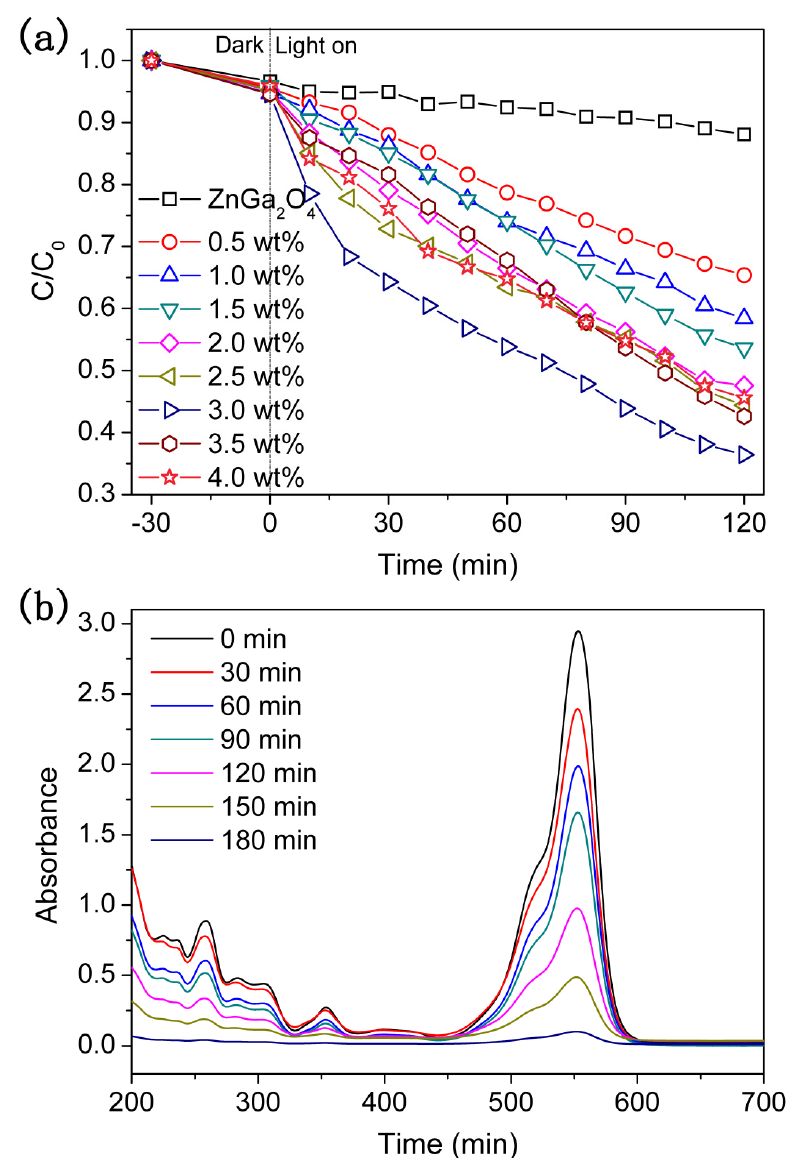
Figure 5. ( a ) The photocatalytic degradation activities of ZnGa 2 O 4 with different amounts of the Au cocatalyst plotted against time; ( b ) The ultraviolet–visible absorption spectra of RhB at different concentrations using 3 wt% Au / ZnGa 2 O 4 photocatalyst. Photocatalytic conditions were: 0.1000 g of photocatalyst, 300 mL of 13.3 ppm RhB solution, 300 W Hg-lamp.